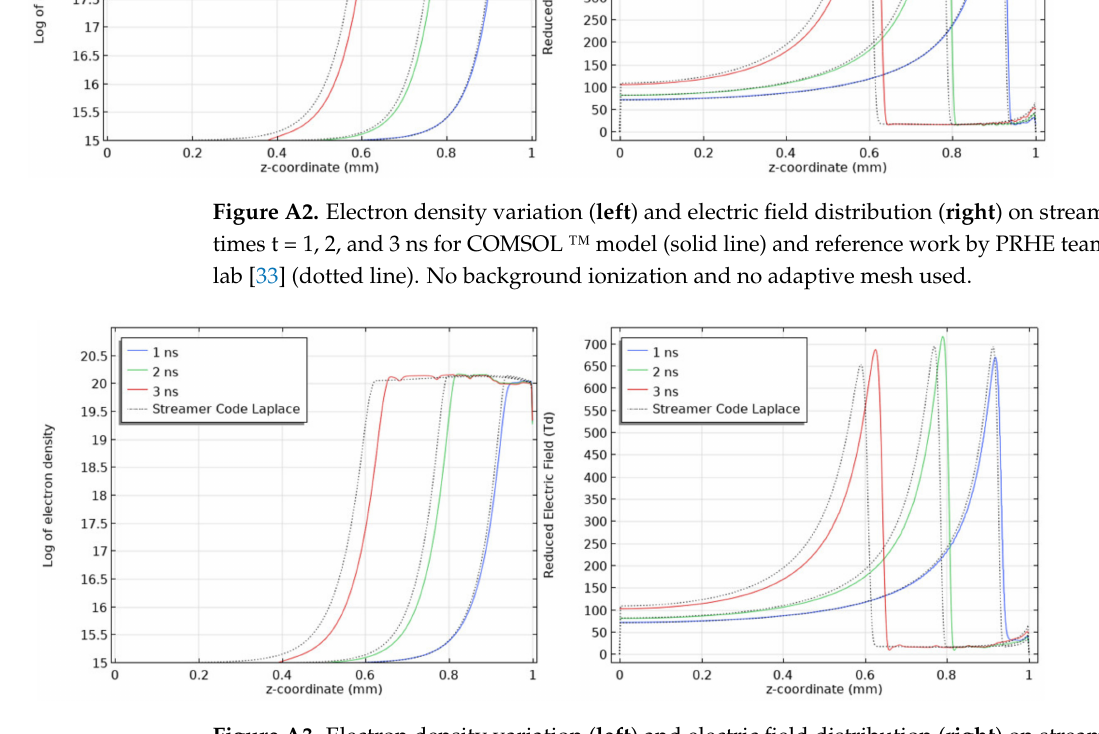
Figure A3. Electron density variation ( left ) and electric field distribution ( right ) on streamer axis at times t = 1, 2, and 3 ns for COMSOL™ model (solid line) and reference work by PRHE team, Laplace lab [33] (dotted line). Adaptive mesh used in COMSOL™ model.